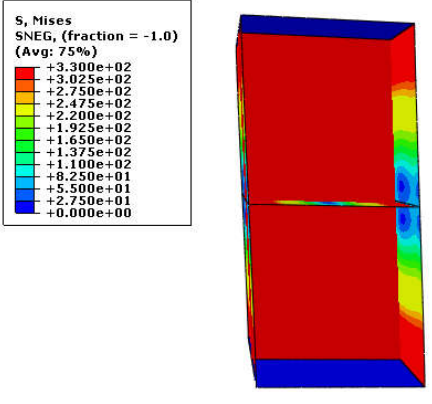
6 of 22 Figure 5. Comparison of load–displacement curve between numerical and experimental models. 3. Main Model